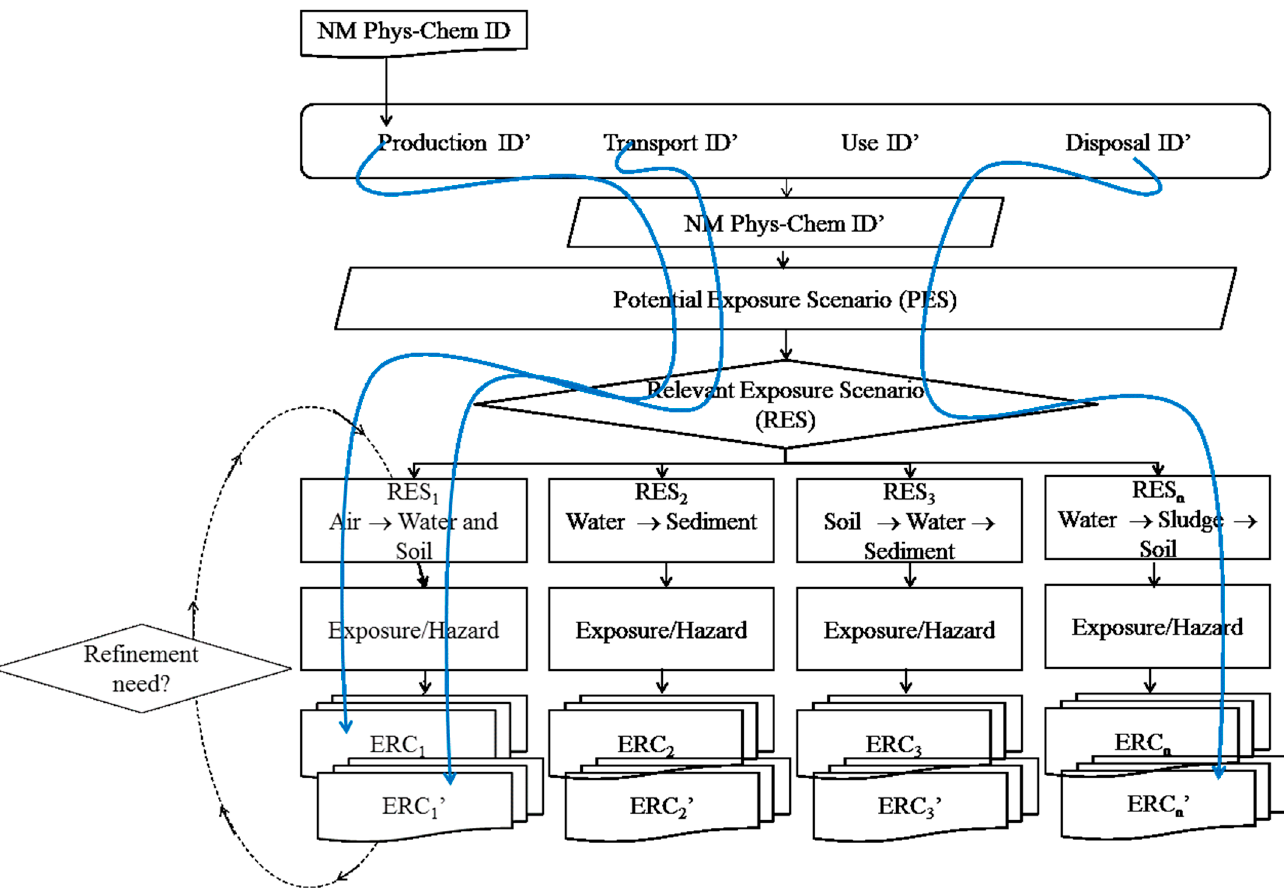
Figure 10. The Overall environmental Risk Assessment flow chart with examples of how one initial NM may result in multiple different (blue arrows) risk characterisations.